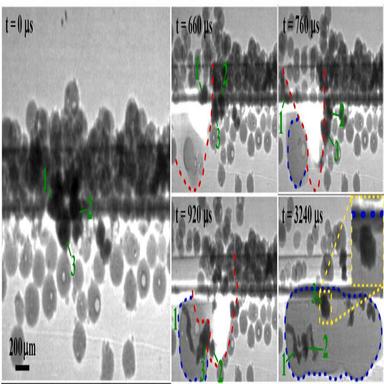
High-speed synchrotron X-ray in-situ imaging of the W20(CoCrFeMnNi)80 melting dynamics with red dashed line that represents the laser induced vapor cavity and molten metal, while the blue dashed line represents the alloyed microstructure. (For interpretation of the references to colour in this figure legend, the reader is referred to the web version of this article.)